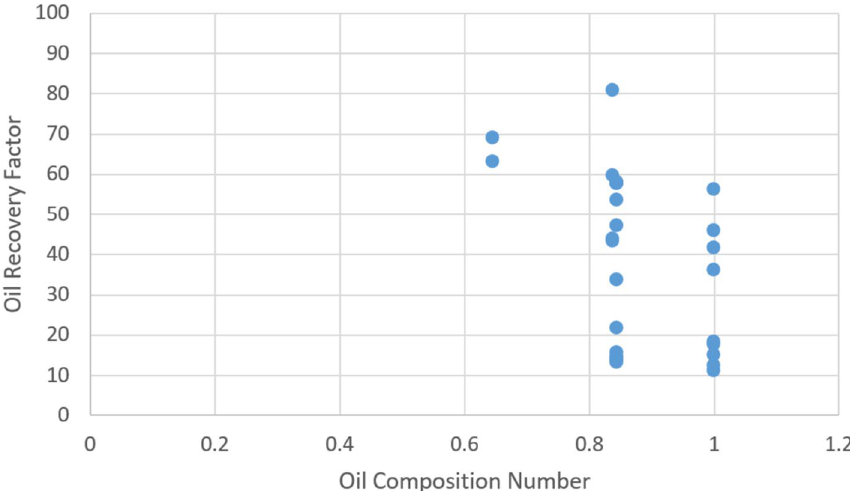
Fig. 5 Oil composition number for CO 2 core-flooding tests